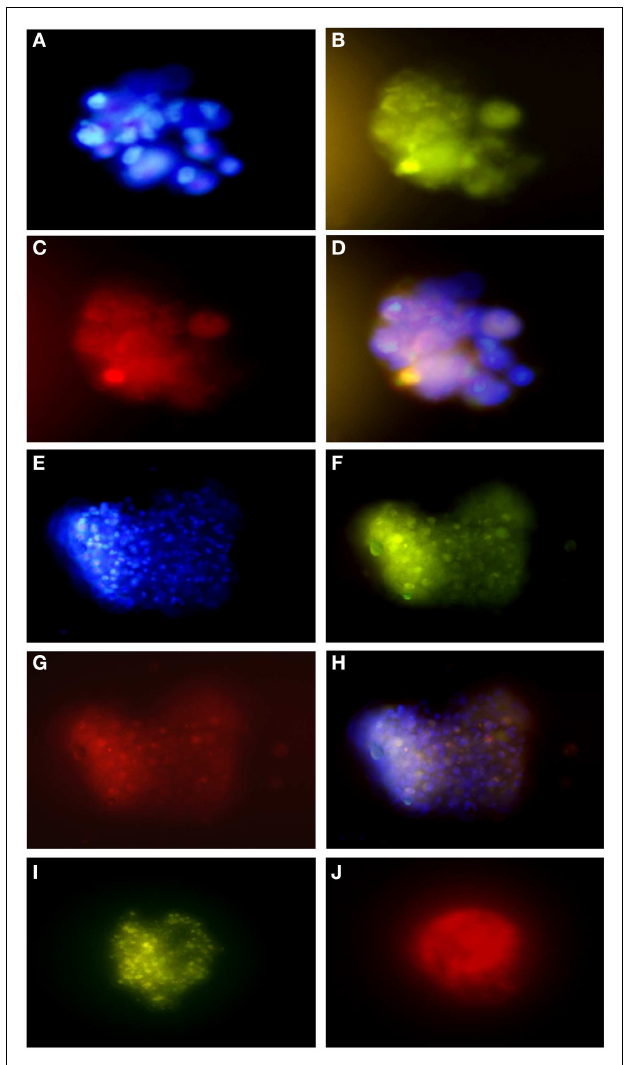
FIGURE 6 | Immunofluorescence assays of glioblastoma subspheres demonstrate the expression pattern of immunophenotypic markers: (A) DAPI, (B) GFAP, (C) CD133, (D) overlay (A–C); (E) DAPI, (F) GFAP, (G,J) Nestin, (H) overlay, (I) Nanog . Representative figure of five samples of glioblastoma. (A–I) Magnification: 600 ×